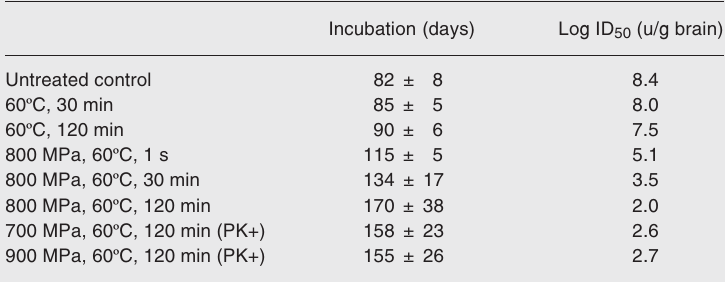
Disease transmission to hamster after intracerebral inoculation of 1.5 mg scrapie- infected brain tissue after heating and/or exposure to 800 MPa at 60 º C for 1 s and 30 and 120 min. The 700- and 900-MPa, 60 º C, 120-min samples were digested with proteinase K (PK, 73 µg/ml, 37 º C, 1 h) before ic inoculation. Results show the mean incubation time (in days) of animals inoculated with the higher concentration, and the log ID 50 /(U/g brain). Surviving hamsters were sacrificed after 270